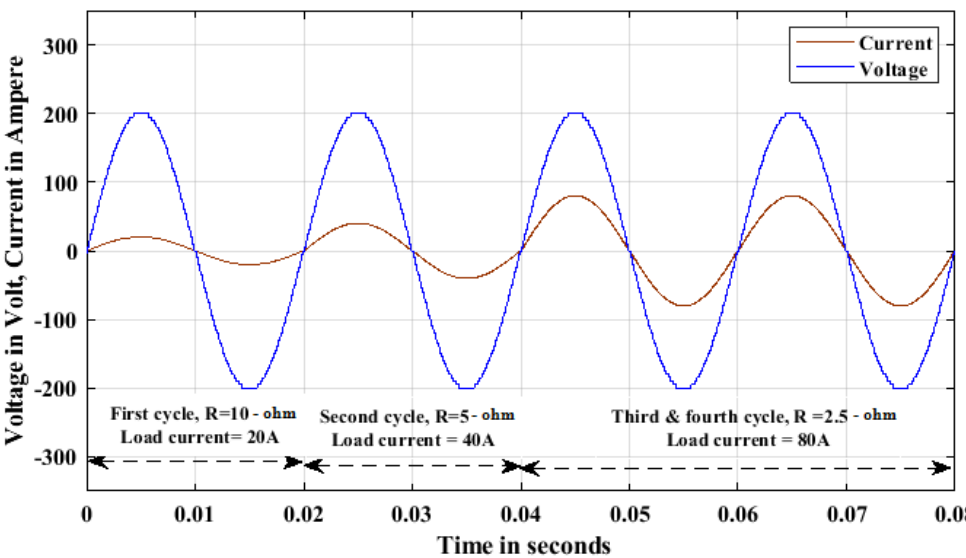
Figure 6. Output voltage and change in current waveforms for variable R load. The harmonic content present in the output voltage and current waveforms are obtained from FFT (Fast Fourier transform) analysis are 1.18% and it is shown in Figure 7a,b.